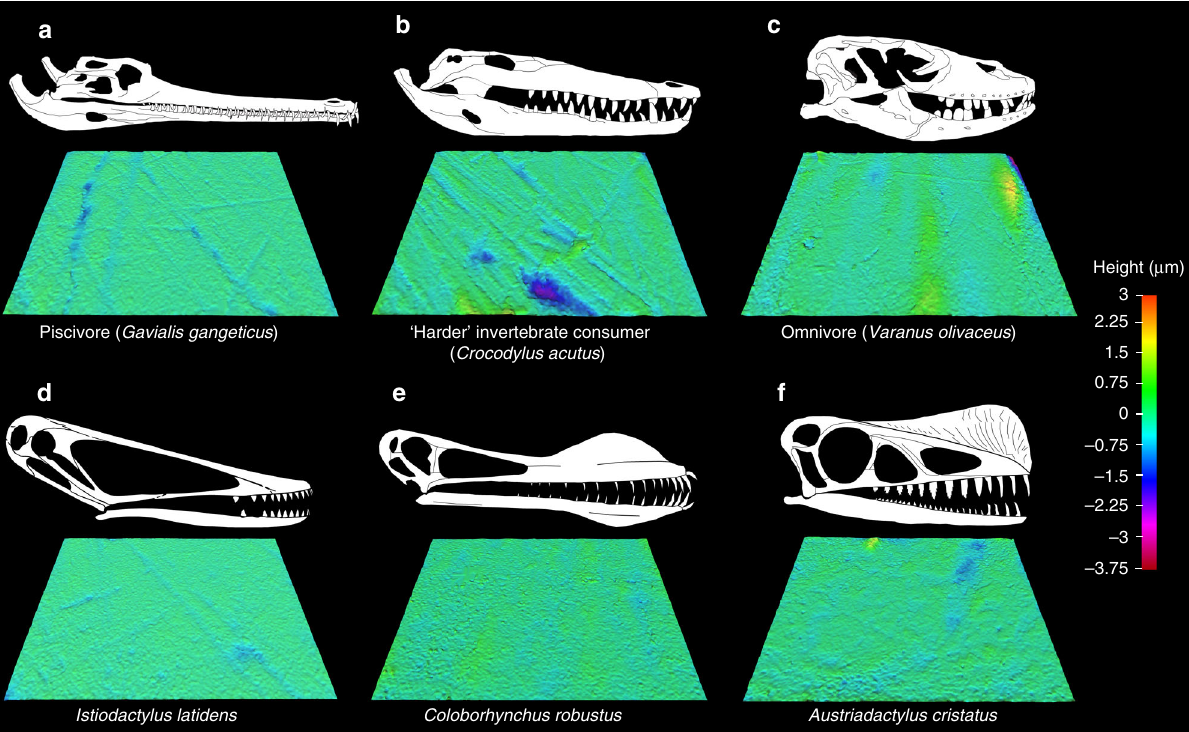
Fig. 1 Example scale-limited tooth surfaces of reptile dietary guilds and pterosaurs. a – c Reptile dietary guilds; a piscivore ( Gavialis gangeticus ; gharial), b ‘ harder ’ invertebrate consumer ( Crocodylus acutus ; American crocodile) and c omnivore ( Varanus olivaceus ; Grey ’ s monitor lizard). d – f Pterosaurs; d Istiodactylus (PCA plot number 16 in Supplementary Fig. 2), e Coloborhynchus (PCA number 5) and f Austriadactylus (PCA number 2). Measured areas 146 × 110 µ m in size. Topographic scale in micrometres. Skull diagrams of extant reptiles and pterosaurs not to scale (see ‘ Methods' for